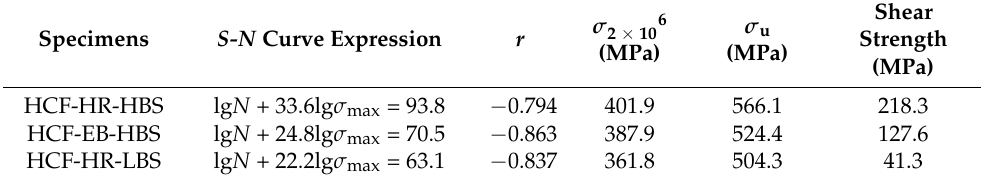
Figure 10. Comparison of the fatigue S-N curves between polished specimens and corresponding original plates.